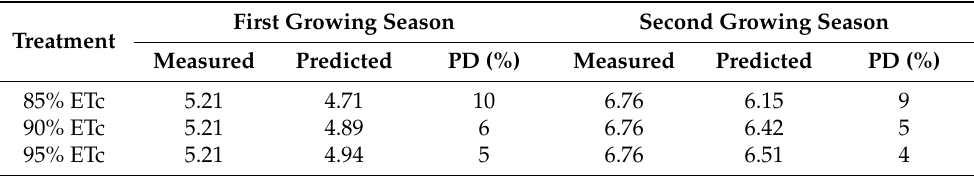
Table 10. Measured versus predicted wheat grain yield under application of 85, 90, and 95% of ETc.